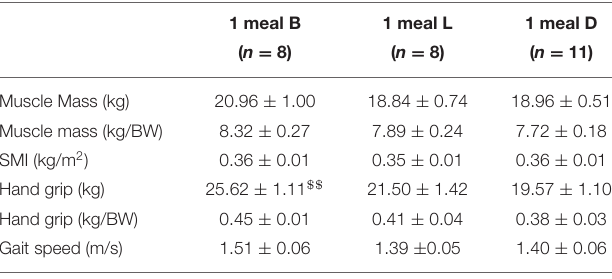
TABLE 2 | Comparison of sarcopenia-related factors between patterns of adequate protein intake with only one meal (Cross-sectional study 2-3). 1 meal B 1 meal L 1 meal